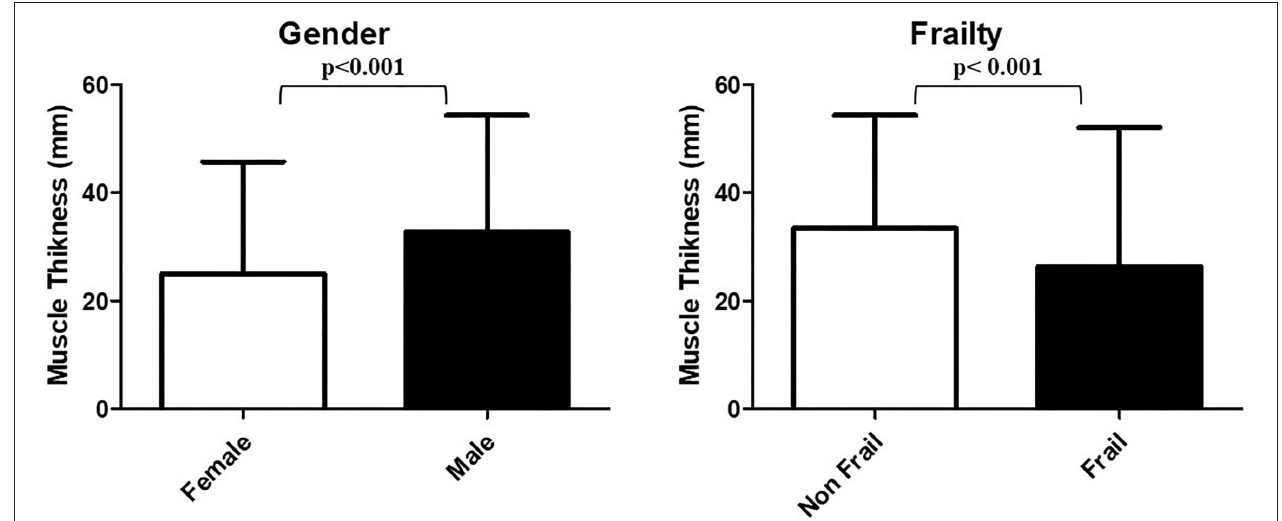
FIGURE 2 | MT values stratified according to gender and frailty status. The p -values correspond to the Mann–Whitney U -test.